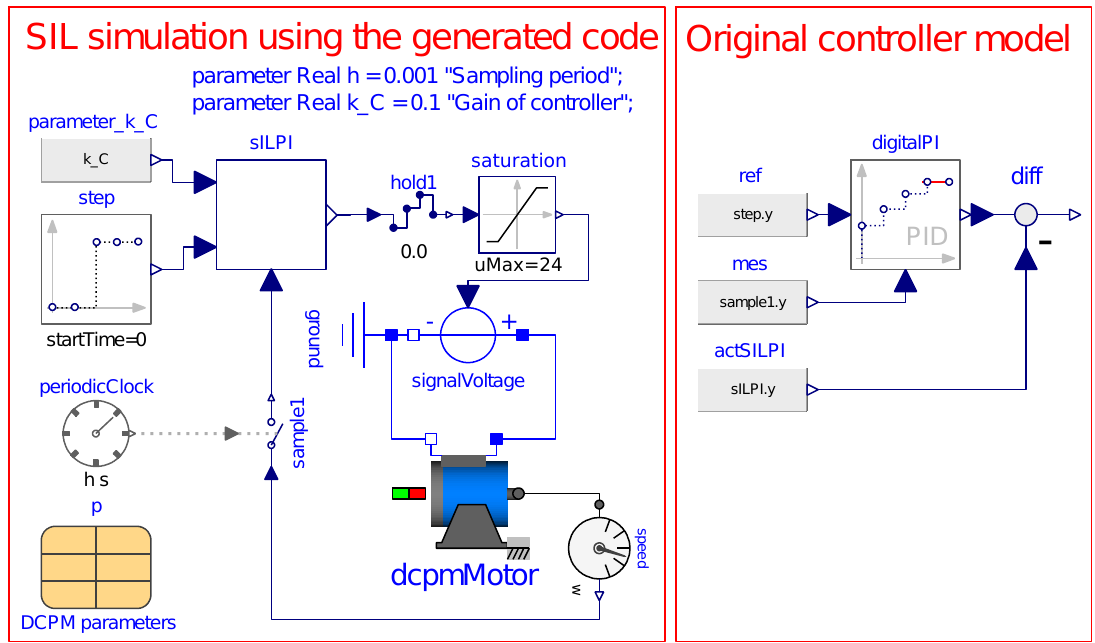
Figure 9: PI(D) controller and plant in a SIL configuration. The generated code is interfaced to the model by using a “wrapper” block (“ sILPI ”). For direct comparison, the original digital PID model (see Figure 8) is included as component “ digitalPI